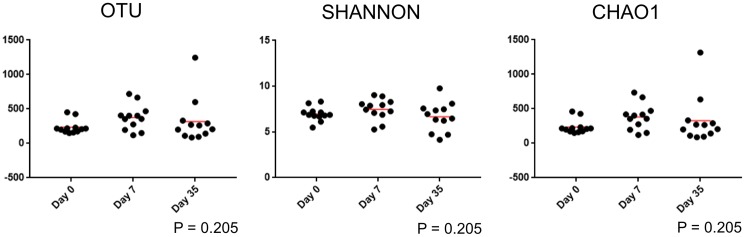
Scatter plots and statistical evaluation of 16S rRNA gene sequences obtained from 12 control eyes of 12 healthy horses at 3 timepoints: day 0, day 7, day 35.There is no difference in alpha diversity in control eyes over time (Friedman test and Dunn’s post-test).